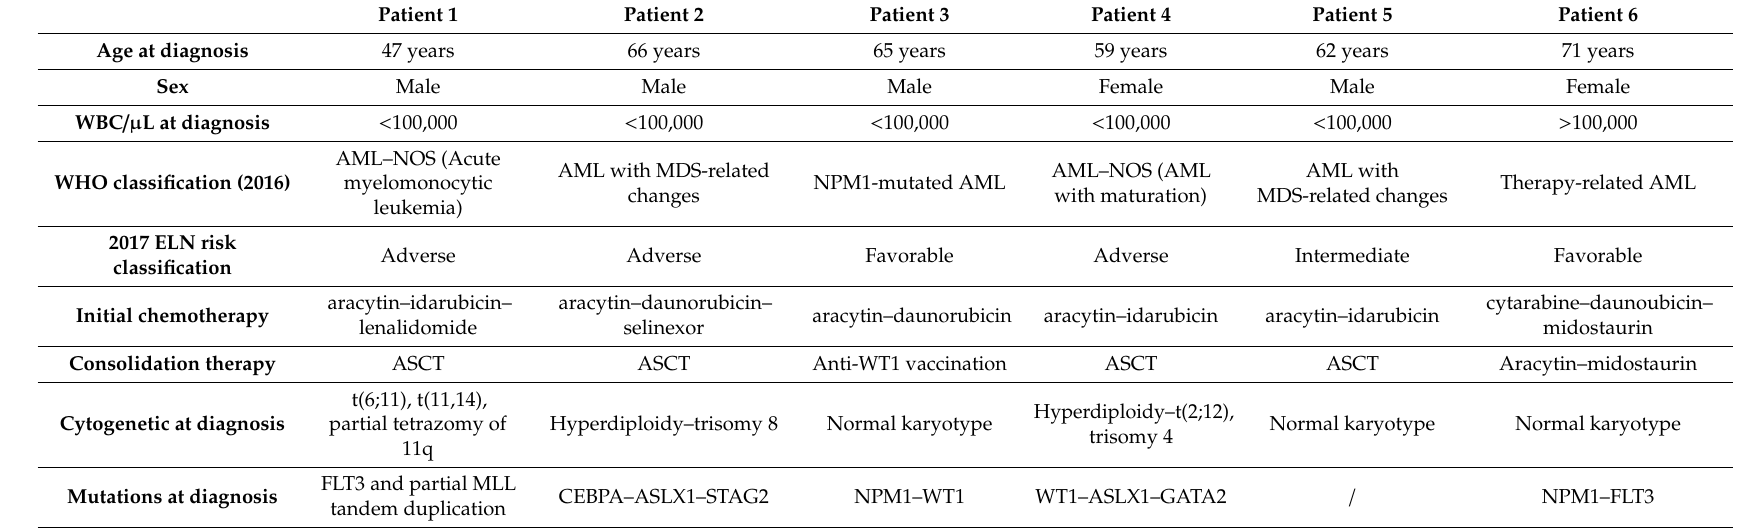
Table 1. Clinical, cytogenetical, and molecular characteristics of six acute myeloid leukemia (AML)